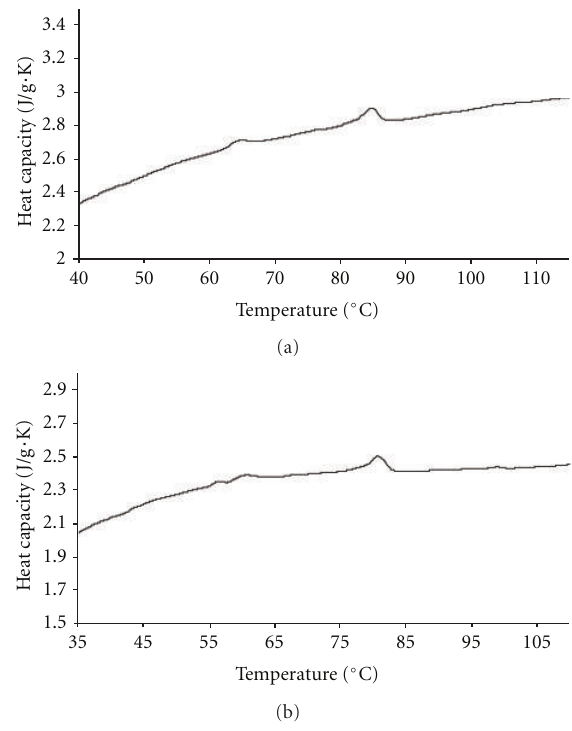
Figure 14: DSC thermograms for cholesteryl nonanoate dispersed in UV15 at scanning rate of 10K · min − 1 , (a) heating, (b) cooling. at transitions. Figures 13(a) and 13(b) at 90.4 ◦ C and 71.6 ◦ C,